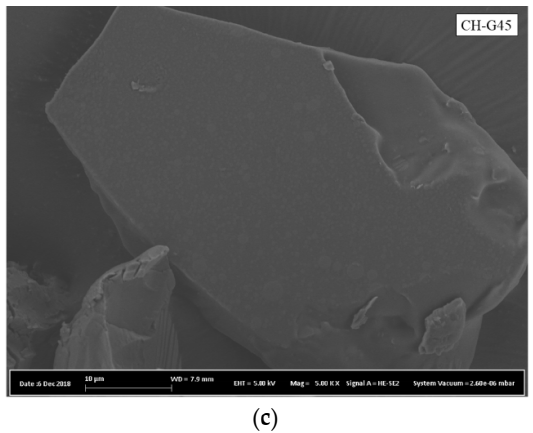
Figure 7. SEM images of EPS produced by cultivation of B. atrophaeus BU4 in glucose- (SM- G15) ( a ) and xylose-based (SM-X8) ( b ) synthetic media, and in a quinoa stalk cellulosic hydrolysate (CH-G45) ( c ). Magnification 5000 × for ( a ) and ( c ), and 10,000 × for ( b ).